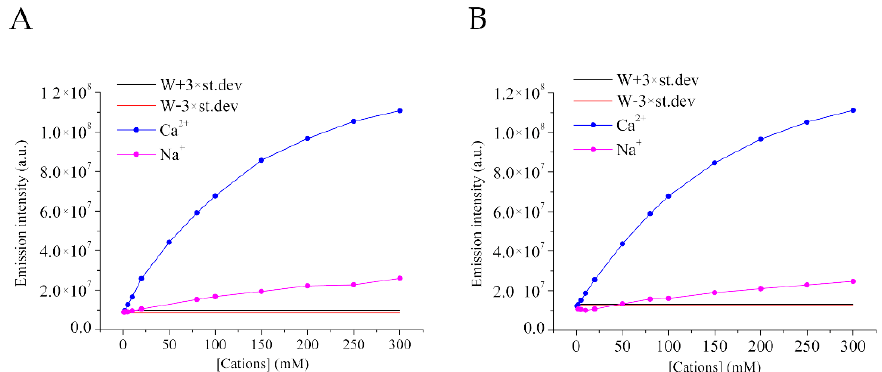
Figure 4 . ( A ) Emission intensities at (Gd 3+ ) = 90 µM. ( B ) Emission intensities at (Gd 3+ ) = 45 µM . (pH = 6.1 ± 0.1).